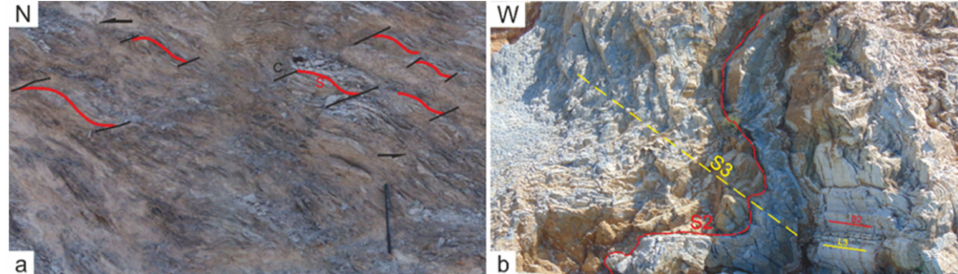
Figure 7. ( a ). S-C’ shear bands, developed in the Lower Schist Fm. with top-to-the-north kinematics (36 ◦ 49 (cid:48) 57 (cid:48)(cid:48) N, 25 ◦ 27 (cid:48) 5 (cid:48)(cid:48) E) and ( b ). Axial planar cleavage (S3) in the N–S isoclinal fold and an N– S intersection/stretching lineation L3 parallel to the B2/3 fold axes (southern part of the island) (36 ◦ 49 (cid:48) 13 (cid:48)(cid:48) N, 25 ◦ 27 (cid:48) 4 (cid:48)(cid:48)